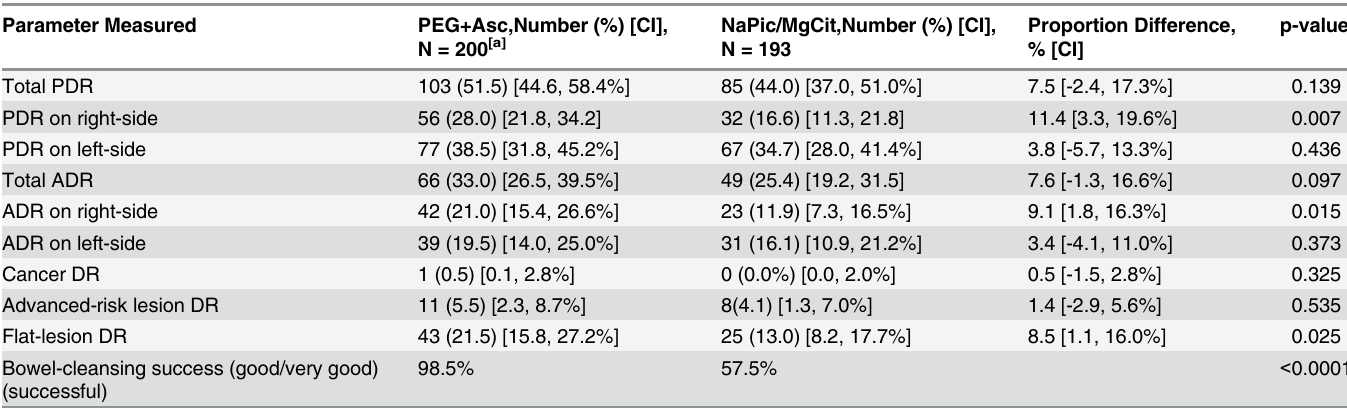
Table 2. Summary Table of Key